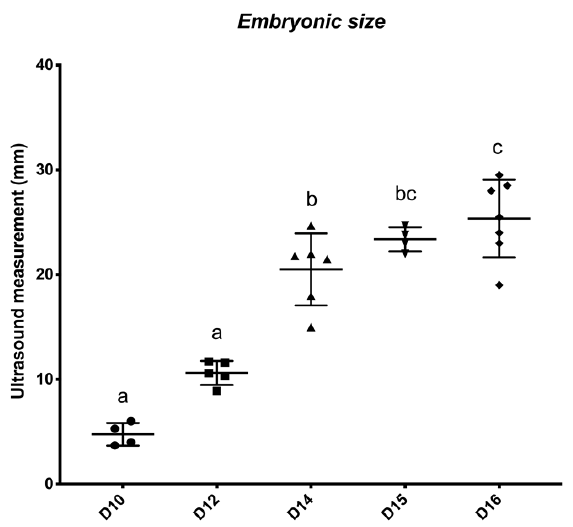
Figure 1. Equine embryonic ultrasound measurements (mm) by embryonic age (Day 10 to 16 post- ovulation). Differences between days ( p < 0.05) are indicated by different superscripted letters. Table 2. Comparisons by day post-ovulation of selected equine embryonic genes at p < 0.05.